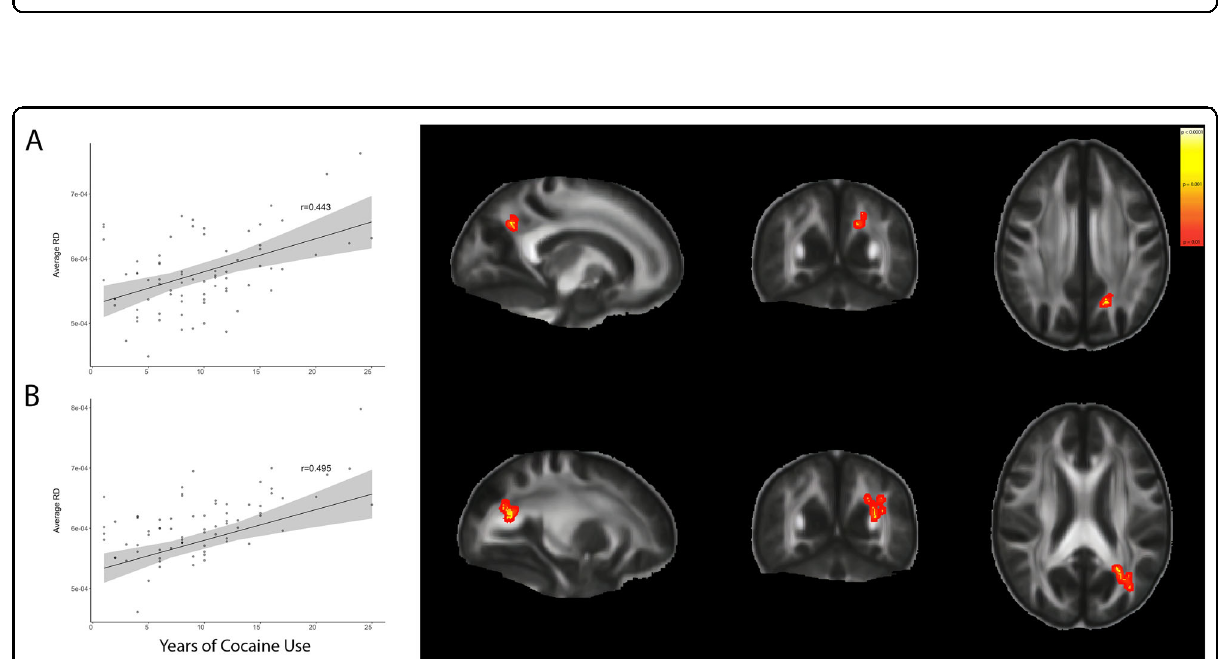
Fig. 2 Years of crack-cocaine use and FA. A Association between years of crack-cocaine use and decrease in FA, as revealed by whole-brain average FA and TBSS analysis. Areas with the signi fi cant negative association in heat scale, the skeleton in green projected onto CUD ’ s average FA image. Sagittal view: x = 62; axial view: z = 86. B Main cluster comprising the genu and body of the corpus callosum, in which there was a strong negative association between the years of crack-cocaine use and FA. Center of mass at MNI coordinates: x = 94, y = 155, z = 81. FA fractional anisotropy, TBSS tract-based special statistics, CUD cocaine use disorder.